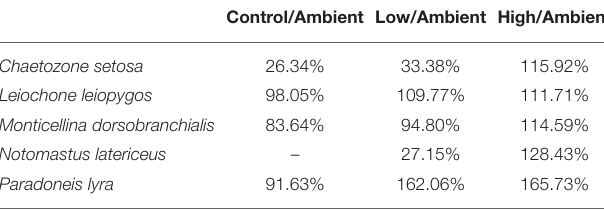
TABLE 4 | Percentage alteration in biomass per individual − 1 from the ambient conditions to the end of the experiment for each group of samples (Ambient, Control, Low eutrophication, High eutrophication) of macrofaunal species responsible for the greater dissimilarity between samples as indicated by the SIMPER analysis.